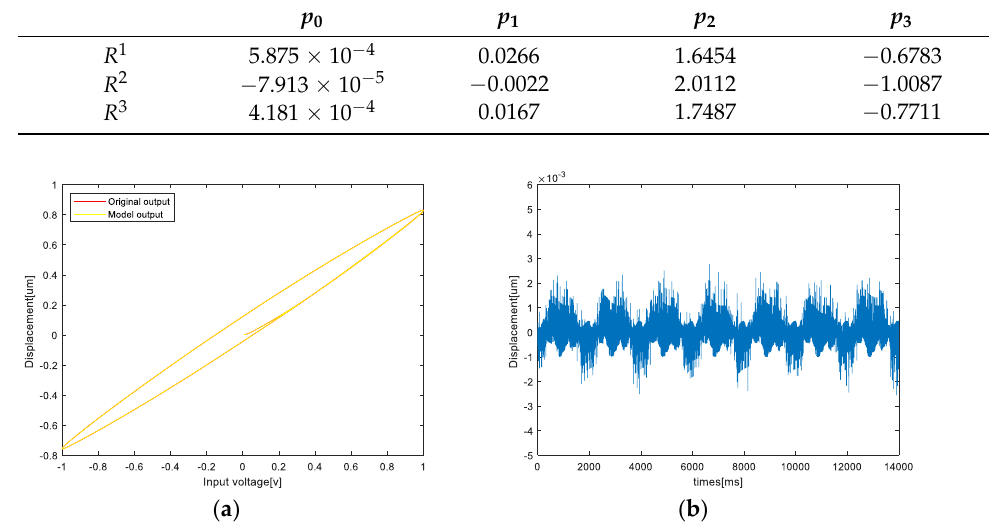
Figure 6. When the input frequency f = 5 Hz: ( a ) jysteresis model; ( b ) modeling error.